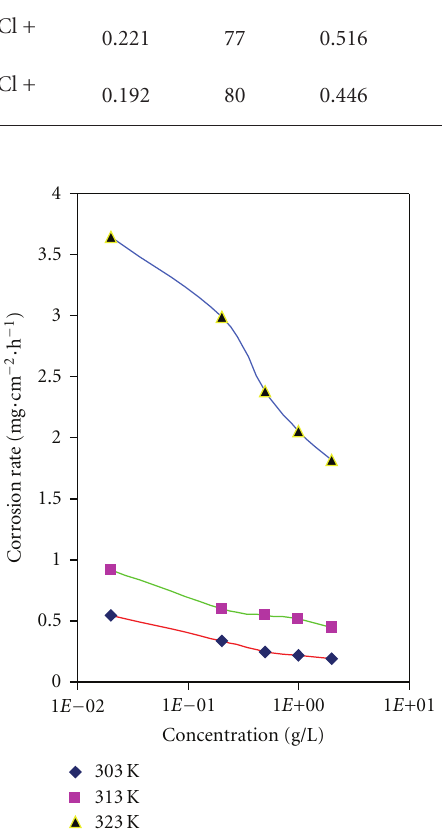
Figure 6: E ff ect of concentration of the aqueous extract of Neem leaves on the corrosion rate (mg · cm − 2 · h − 1 ) of carbon steel in 1.0 M HCl at various